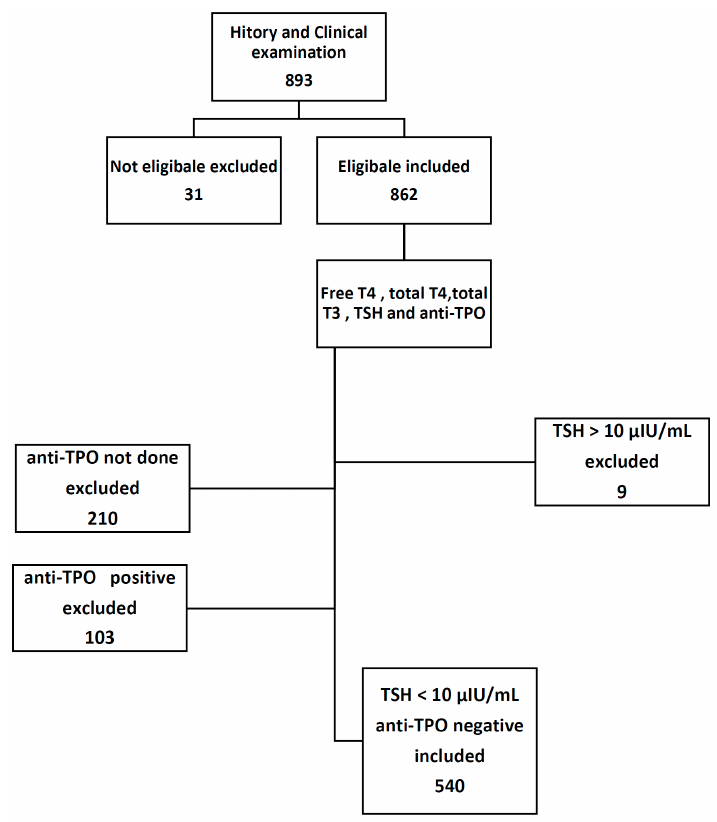
Figure 1. Study protocol.